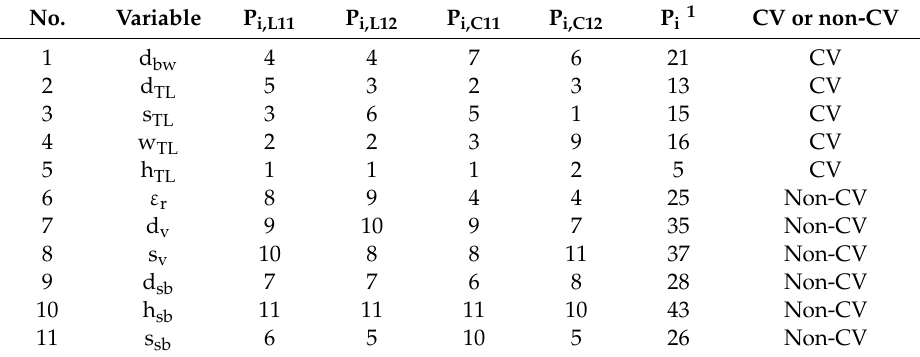
Table 3. Priority analysis for critical variable (CV) determination.